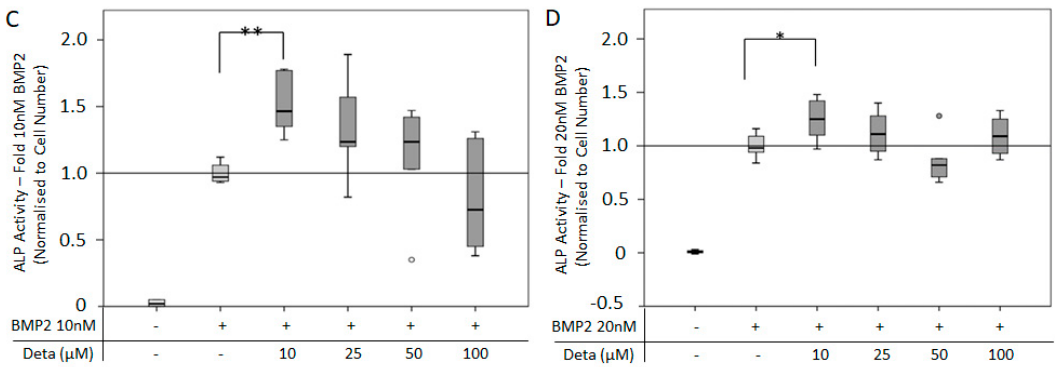
Figure 5. ALP activity after NO supplemented BMP2 stimulation: ALP activity normalized to cell number of C2C12BRELuc cells stimulated with direct NO donor Deta NONOate (10–100 μ M) ( A ) without BMP2, ( B ) with 4 nM BMP2, ( C ) with 10 nM BMP2, or ( D ) with 20 nM BMP2. Statistics: Kruskal–Wallis Test followed by Mann-Whitney U test. Mann-Whitney U test significances between samples were assigned if p < 0.05 (*) or p < 0.01 (**). Abbreviation: Deta = Deta NONOate. Circles are outlying values. Replications ( A – B ) n = 6.